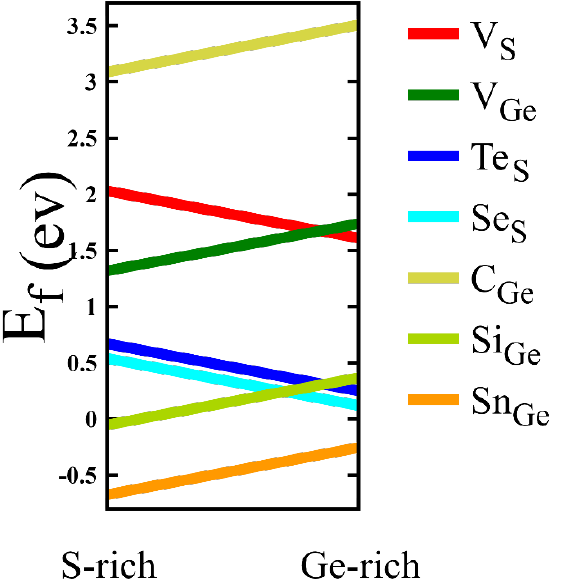
Figure 3. Formation energies of defected structures as a function of chemical potential.